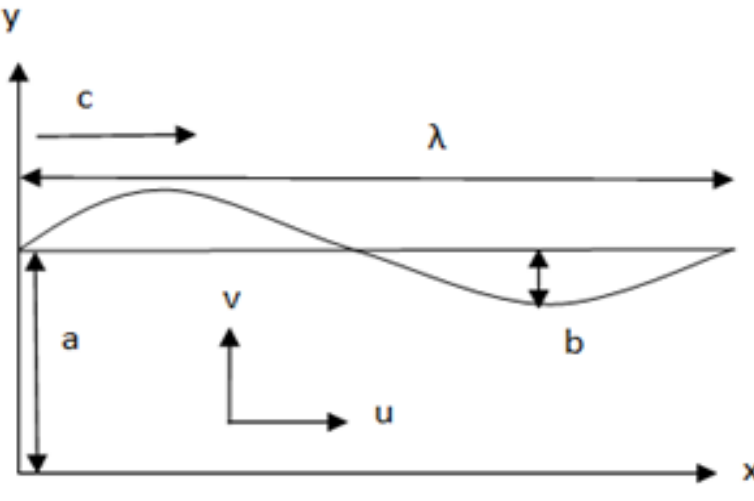
Fig. 1. Geometry of the peristaltic